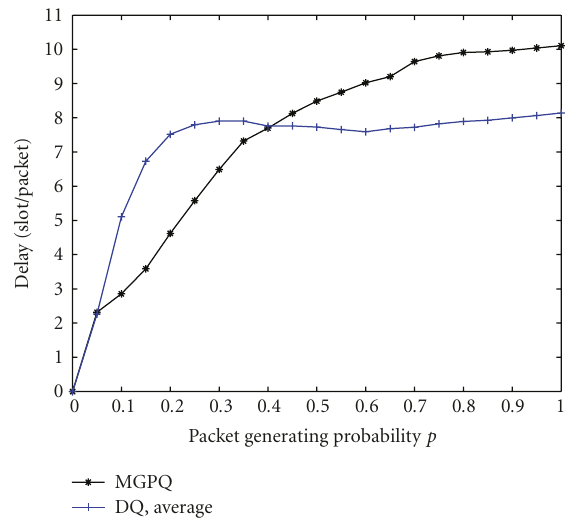
Figure 6: Delay performance comparison between MGPQ and DQ.